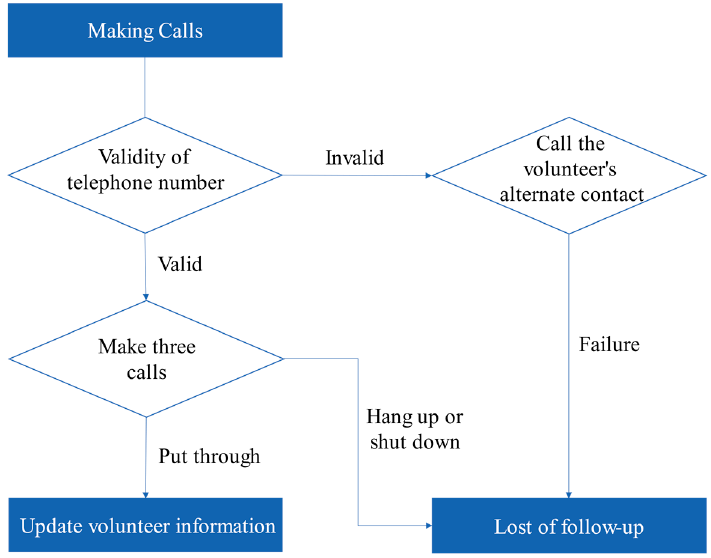
Figure 1. Telephone follow-up flow